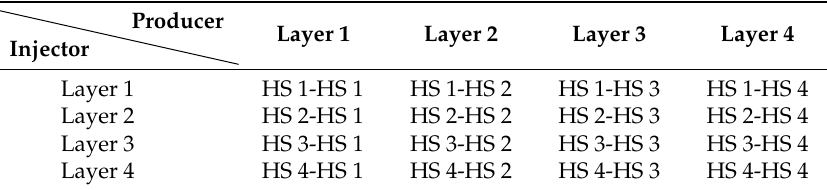
Table 7. Well pattern descriptions of the HS-HS group.